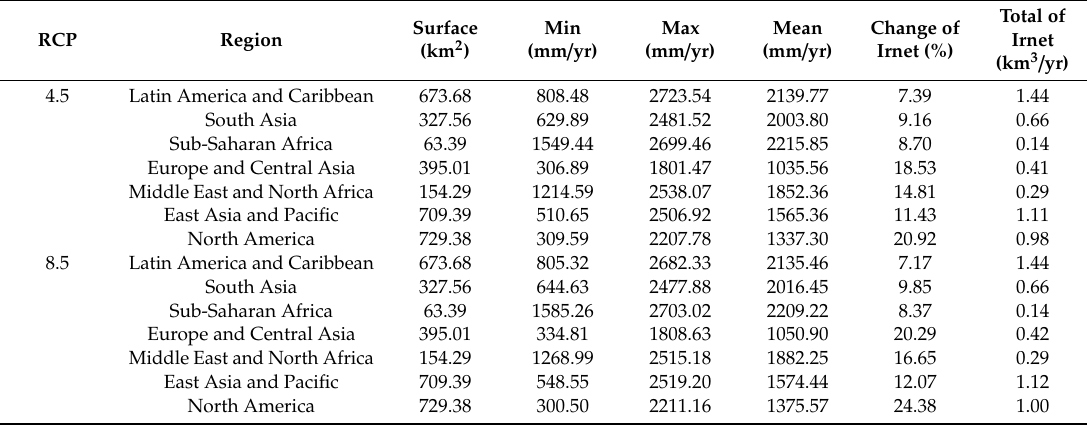
Table 5. MIROC 5 regional net irrigation water